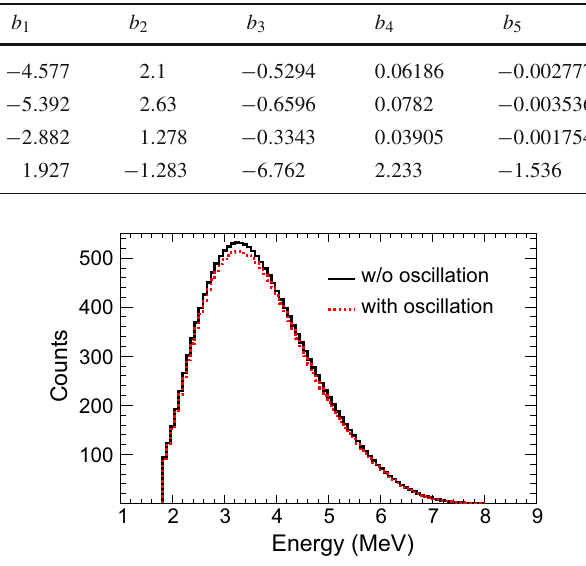
Fig. 2 Simulated event distribution without and with active-sterile neutrino oscillation after incorporating detector response. Oscillated events are estimated with Δ m 2 = 1.7 eV 2 and sin 2 2 θ 14 = 0 . 41